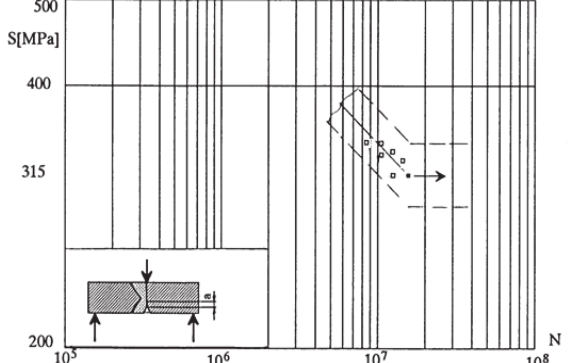
Figure 4: S-N Relationship for specimens with initial crack a = 0.25 mm.